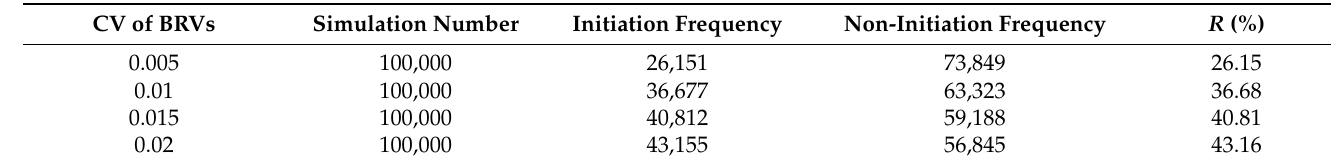
Table 11. The calculation results of the GABP-MCS in the IP study under the shock load condition where v is 1000 m/s.